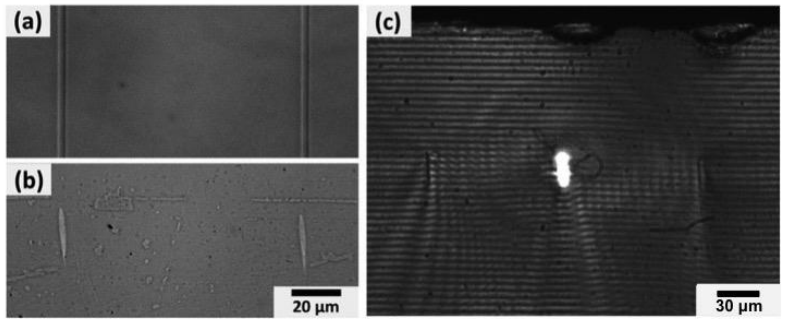
Figure 10. Images of waveguides produced in boron-based glass by femtosecond-laser pulses. Top ( a ) and cross-section view ( b ) of two parallel waveguides are illustrated along with the near-field output profile of the light guided at 632.8 nm ( c ). Reprinted with permission [99]. Copyright (2015), Elsevier.